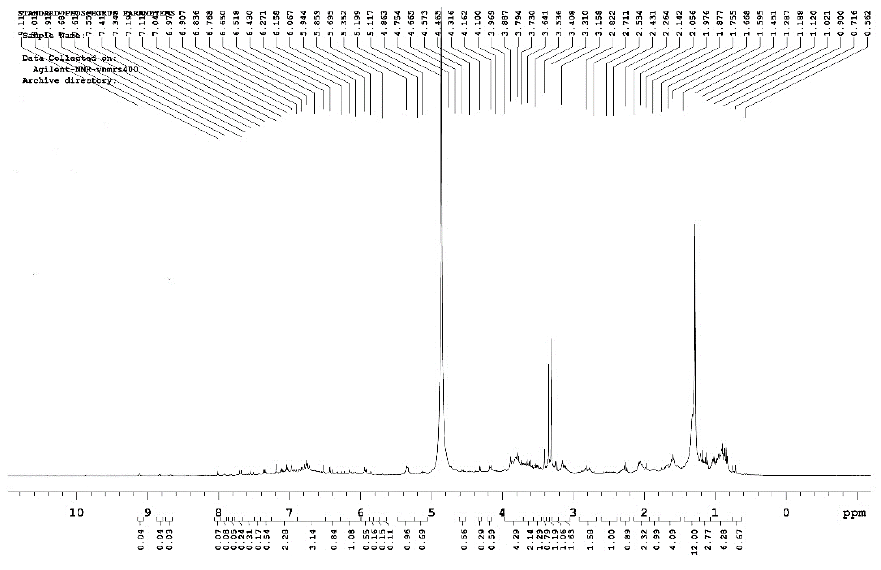
Figure 6. 1 H-NMR spectra of RPB